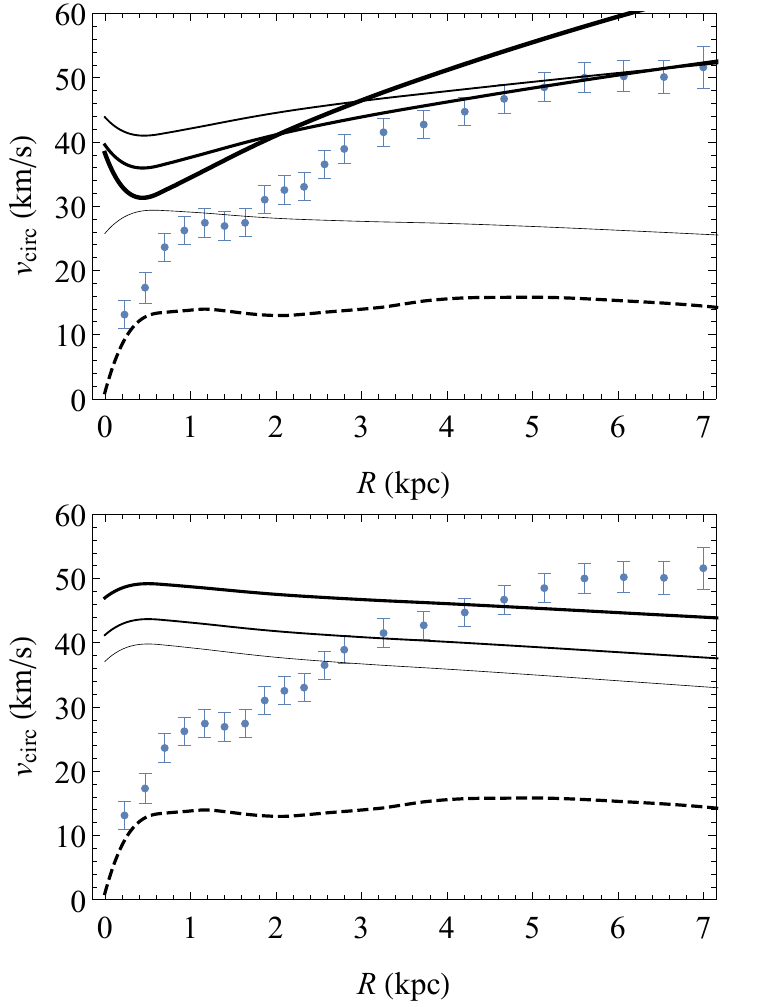
Figure 13 . Comparison of the data points of NGC3741 with the n = 0 rotation curve of the theory T with weighted derivatives in the extreme fractional regime with a data-based matter v density profile for α = 1 (Einstein’s theory, dashed curve), α = 0 . 80 , 0 . 55 , 0 . 50 , 0 . 40 (top panel, increasing thickness) or α = 2 / 3 and R = 10 , 20 , 60 kpc (bottom panel, increasing ∗